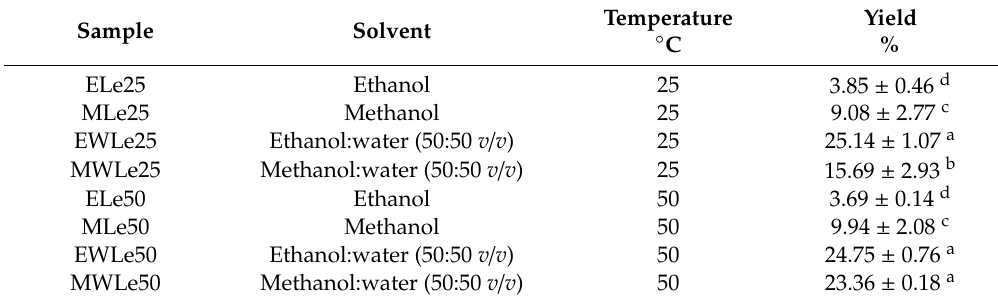
Table 1. Extraction yields (% mass extracted related to the mass of licorice root) of licorice root ultrasound-assisted extraction